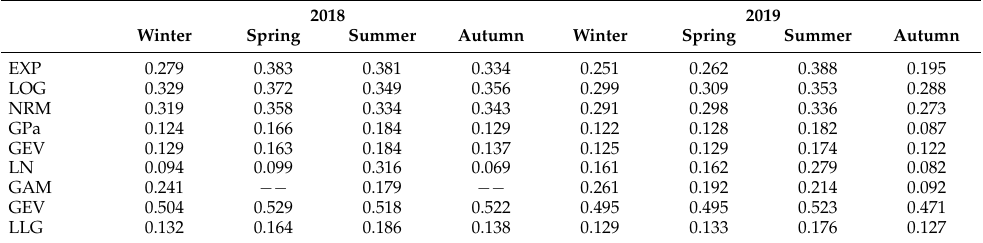
Table 13. KS-test results for the L-moment estimation, for the 600 m threshold.